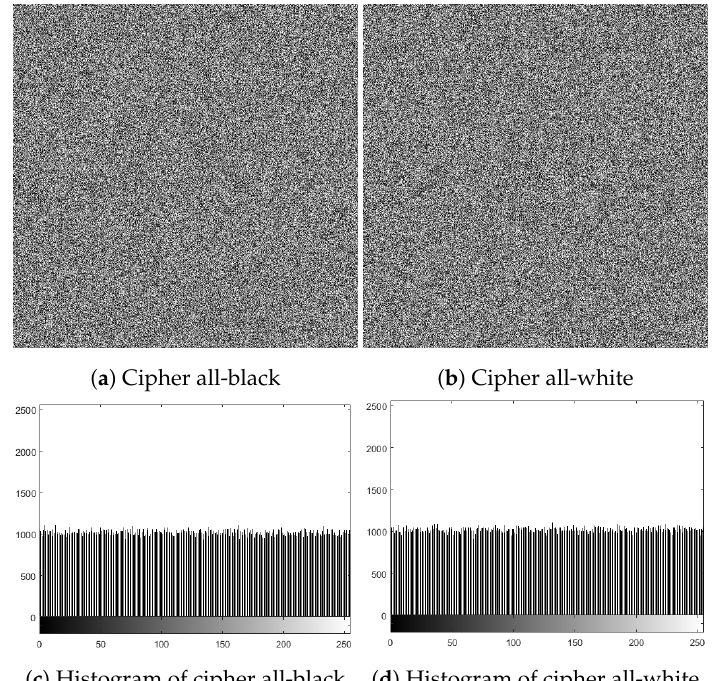
Figure 16. Ciphers of all-black and all-white images, and their analog